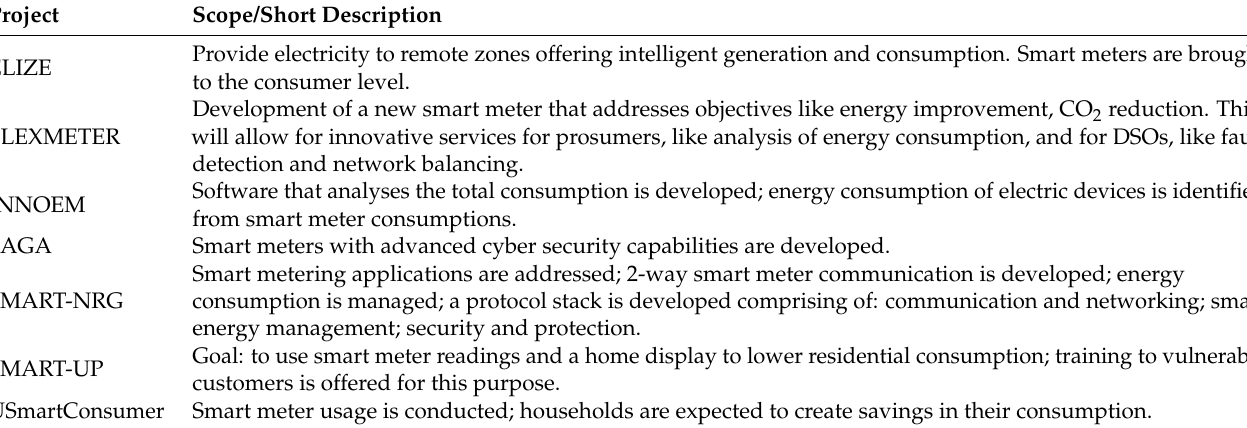
Table 5. Smart Metering Applications.